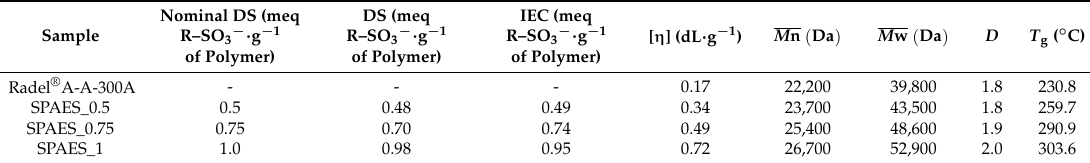
Table 2. List of SPAESs synthesized with their DS, IEC, intrinsic viscosity values ( η ), number average molecular weights ( M n), weight average molecular weights ( M w), molecular weight distribution ( D ), and T g values. SEC data are expressed in PS